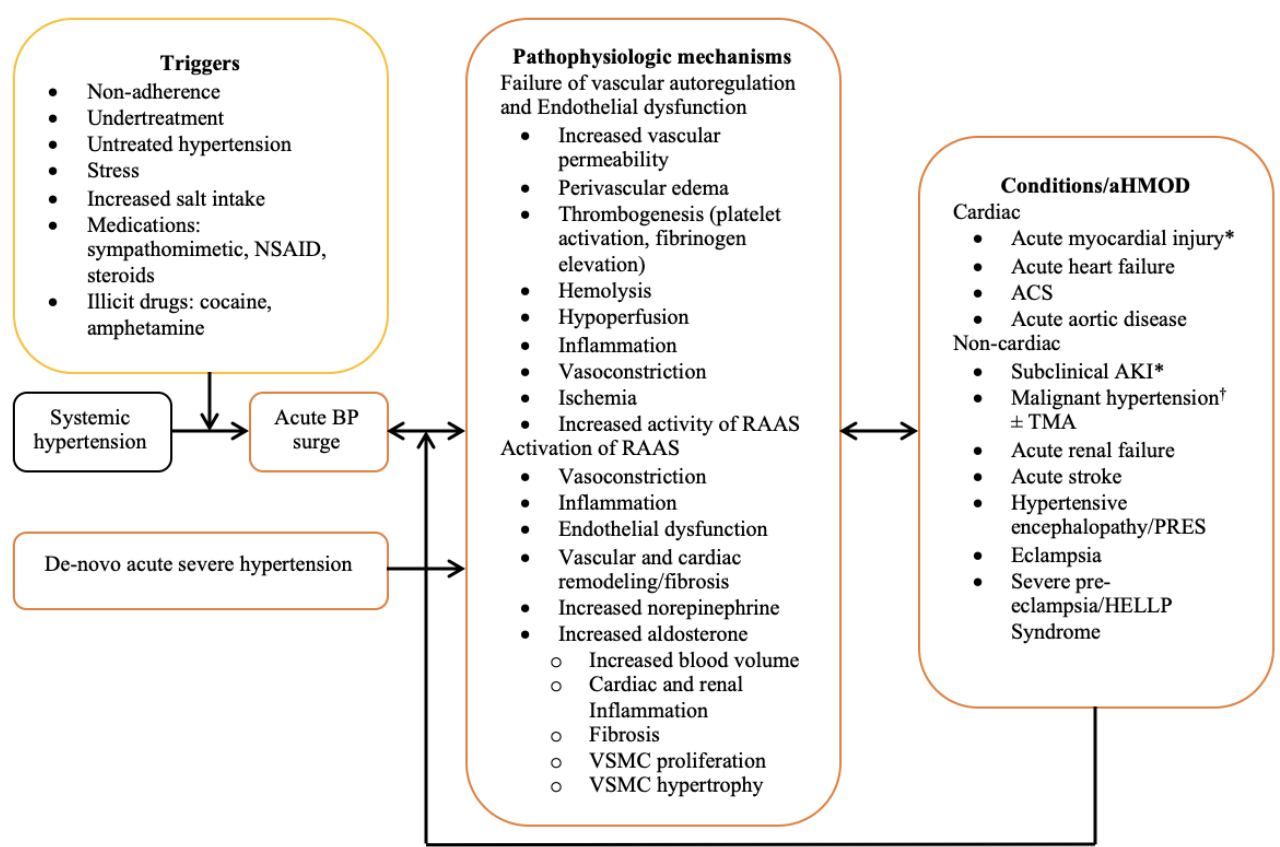
Figure 1. Summary of the pathophysiologic processes in acute hypertension-mediated organ injury. ACS; acute coronary syndrome; AKI, acute kidney injury; aHMOD, acute hypertension-mediated organ damage; BP, blood pressure; HELLP, hemolysis, elevated liver enzymes, low platelets; NSAID, nonsteroidal anti-inflammatory drug; PRES, posterior reversible encephalopathy syndrome; RAAS, muscle cell; * Not listed as acute hypertensive target organ damage in guidelines; † presence of retinal exudates, hemorrhage ± papilledema.